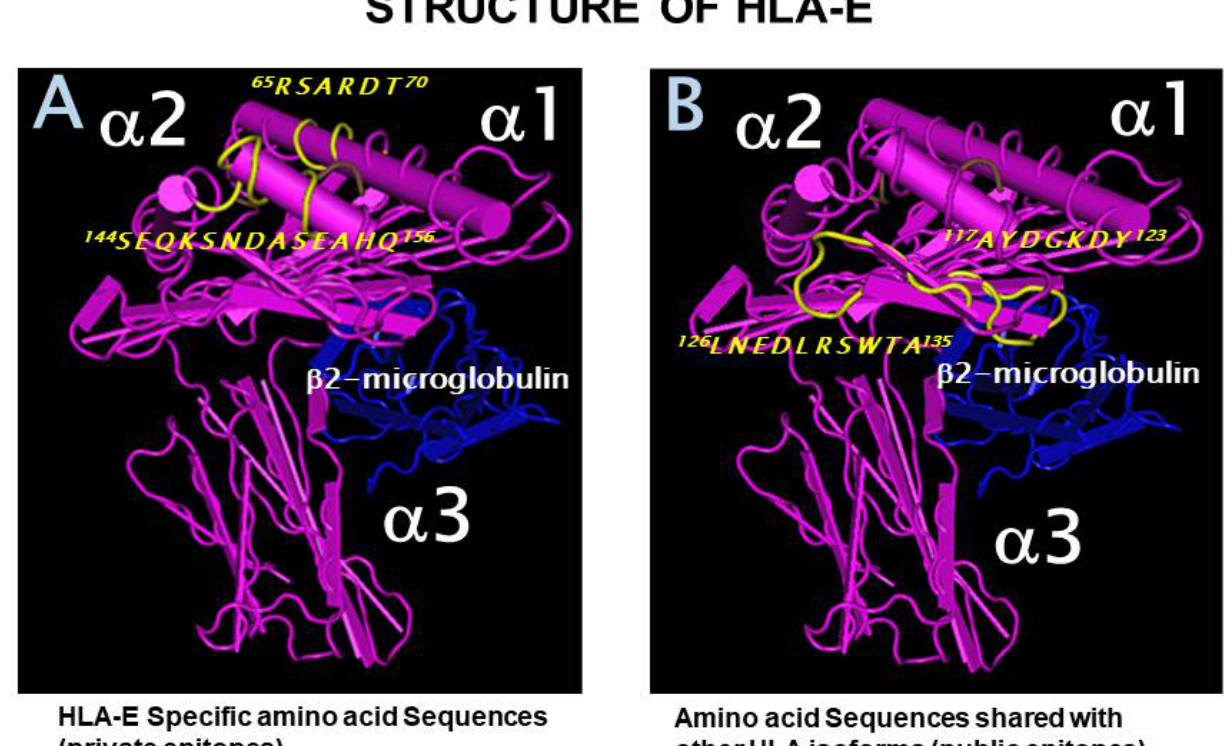
Figure 1. HLA-E structure shows specific amino acid sequences, private epitopes, shared amino acid sequences, or public epitopes. ( A ). Private epitopes recognized by the anti-HLA-E monospecific mAb, TFL-033 ( B ). Public epitopes are recognized by the anti-HLA-E mAbs, TFL-006, and TFL-007. Both private and public epitopes are shown in yellow.